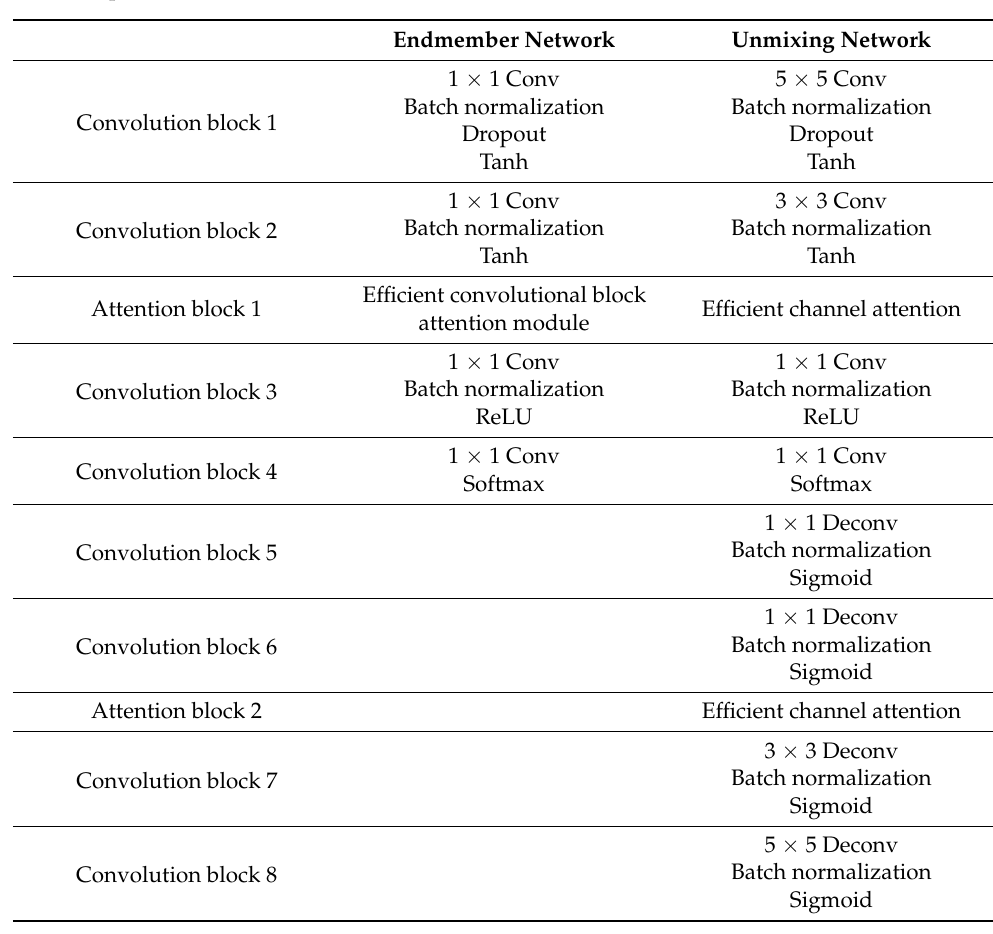
Table 2. Specific network details of the